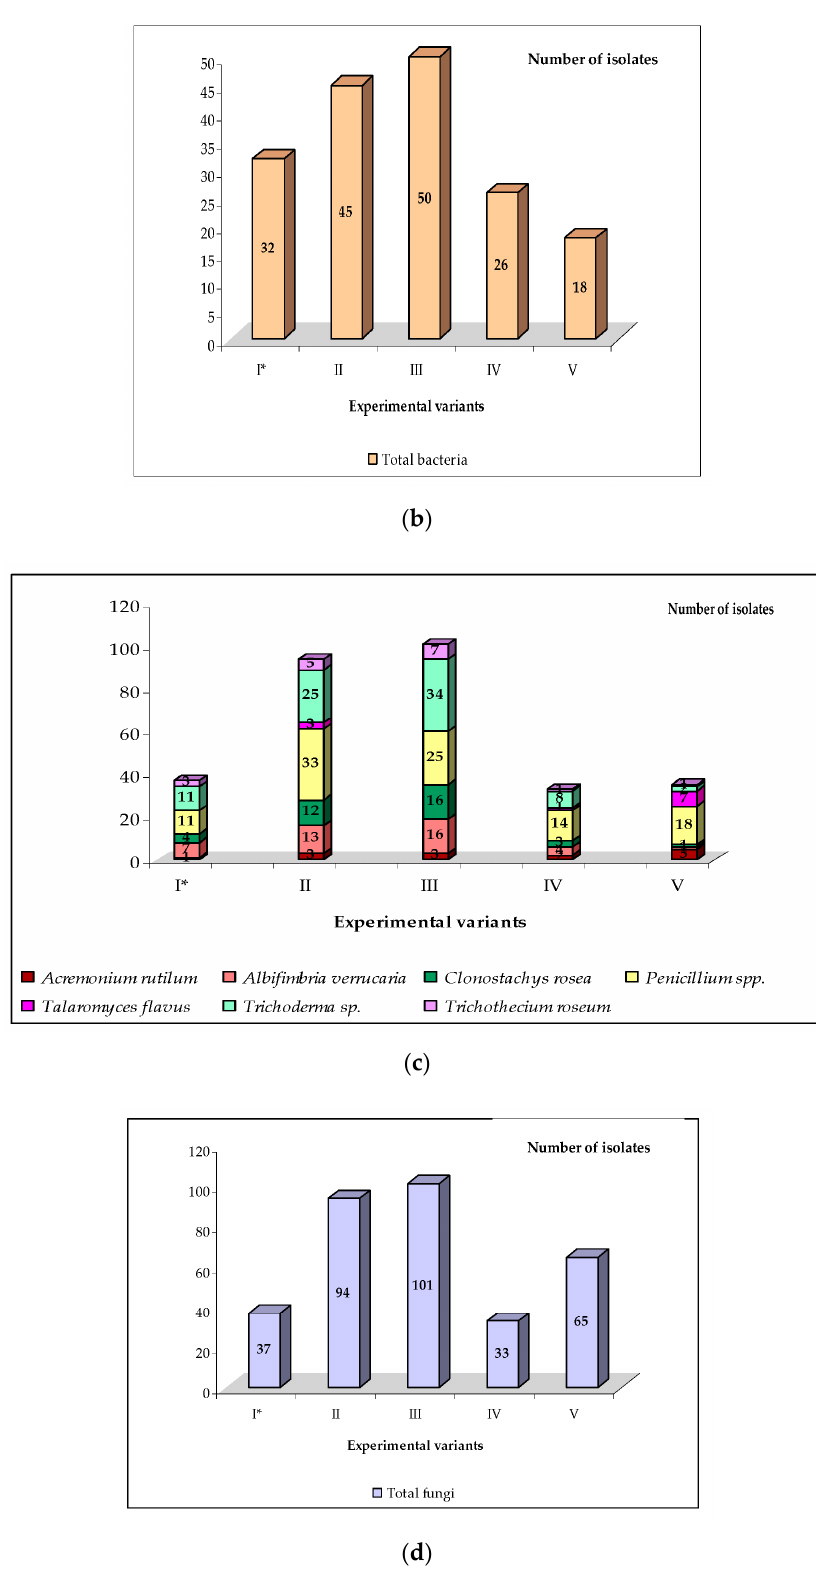
Figure 6. Antagonistic microorganisms in the rhizosphere of scorzonera: ( a ) Pseudomonas sp. and Bacillus sp.; ( b ) total bacteria; ( c ) antagonistic fungi; ( d ) total fungi. I*—Biosept Active, II—Timorex Gold 24 EC, III—Trianum P, IV—Zaprawa Nasienna T 75 DS/WS,